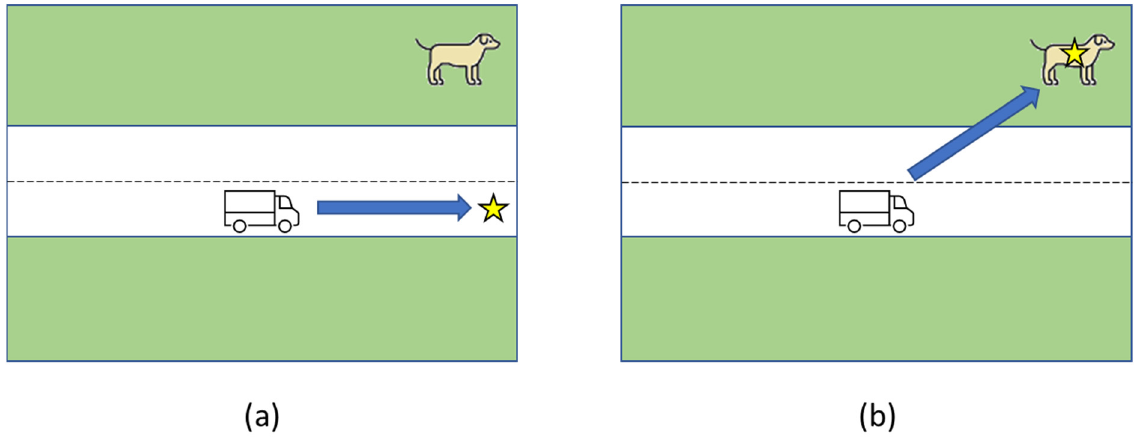
Figure 9. Two examples of motor schema behaviors: ( a ) Stay-of-Path; ( b ) Follow-Leader.